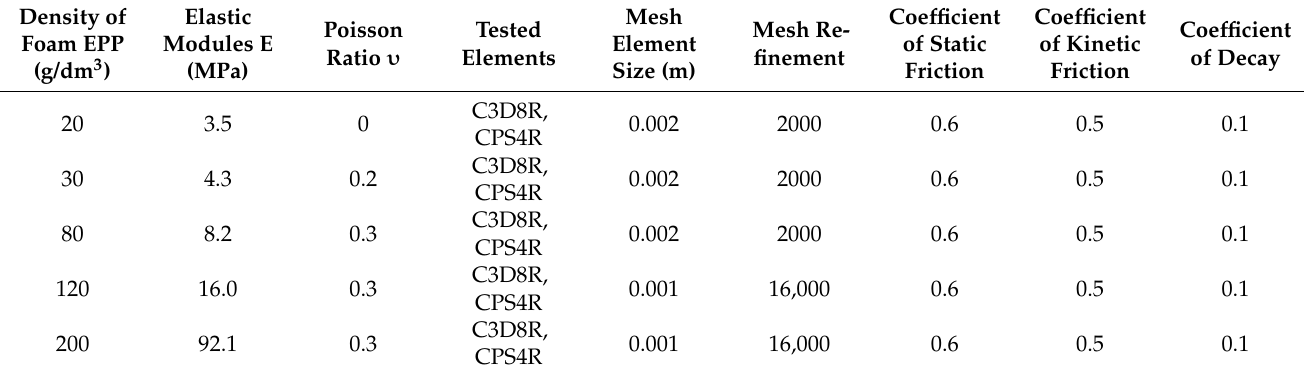
Table 2. Material and element properties for the model used in the numerical